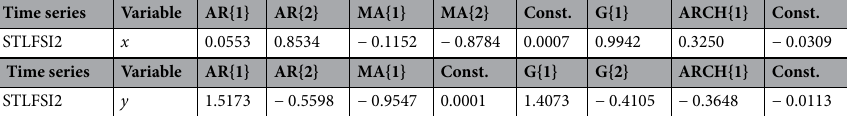
Table 4. ARIMA-GARCH* (2,1,2)-(1,1) coefficients for variable x and ARIMA-GARCH* (2,1,1)-(2,1) coefficients for variable y , listed according to the AR-I-MA-G-ARCH parts of the algorithm (where two of the constants appearing in the ARIMA as well as in the GARCH parts have been added, leading to 16 (instead of 20) parameters to be listed).